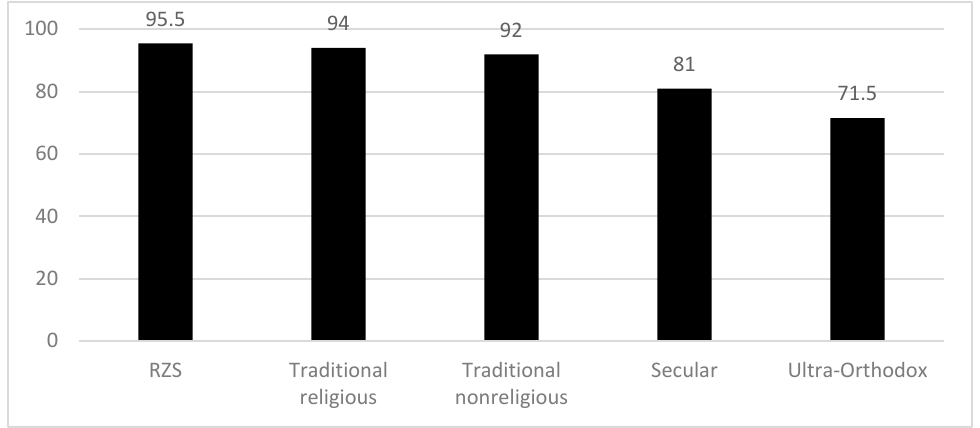
Figure 5. Proud to be Israeli, by level of religiosity (%) (Source: Israeli Democracy Index, 2014 ‒ 2021).